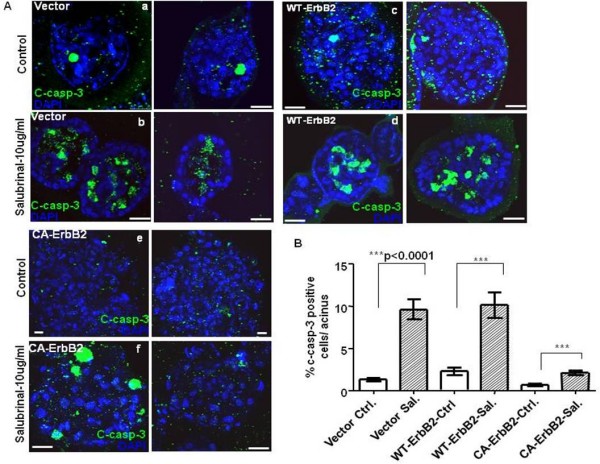
Salubrinal treatment induces apoptosis and accelerates luminal clearing in control and wild type ErbB2 acini. (A) Two representative confocal images of equatorial cross-sections of day 10 vector control, wild type and constitutively active ErbB2 acini stained for cleaved caspase-3 (c-casp-3; green) or DAPI (blue). Untreated acini (panels a, c and e) and salubrinal treated acini (panels b, d and f). Note increase in c-caspase-3 stained cells within the luminal space in salubrinal-treated vector and Wt-ErbB2 acini. Scale bars = 25 μm. (B) Graph showing distribution of the percentage of cells per acinus that stained positively for c-caspase3; mean ± SEM. Statistical significance was determined using the unpaired t-test with p < 0.05 defined as statistically significant. N.S - not significant.